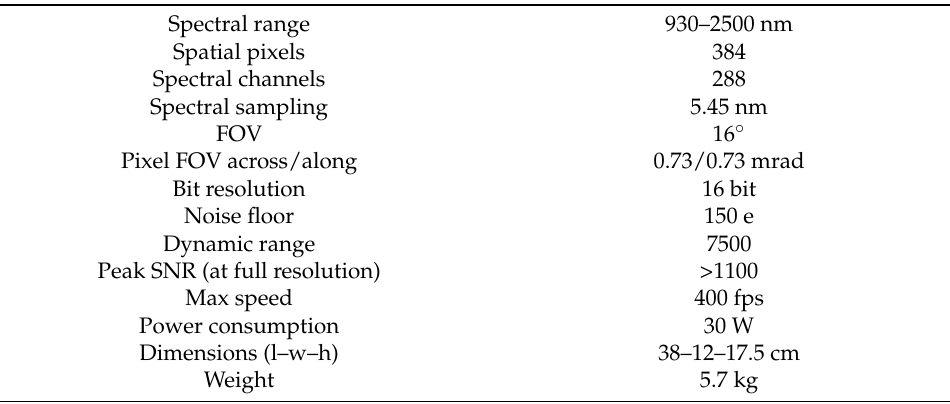
Figure 1. Location map of the study area ( a ) and the survey zone is marked with red square field photograph in the study by UAV ( b ). Table 1. The technical specification for HySpex